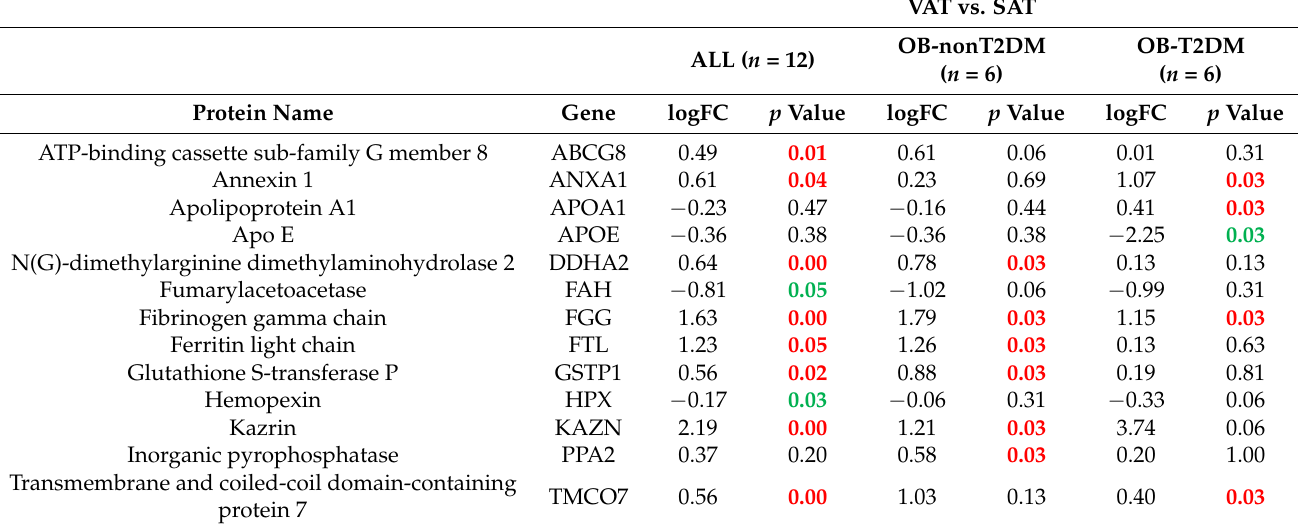
Table 2. Significance of changes in differential protein expression of SAT versus VAT in obese individuals (with and without T2DM); obese without T2DM individuals (OB-nonT2DM) and obese with T2DM individuals (OB-T2DM).